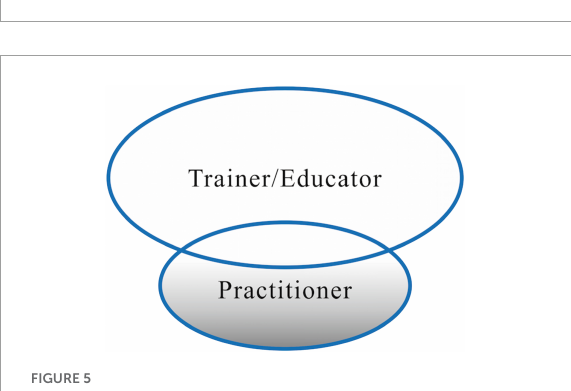
FIGURE4 Researcher and practitioner role identity interaction as overshadowing.